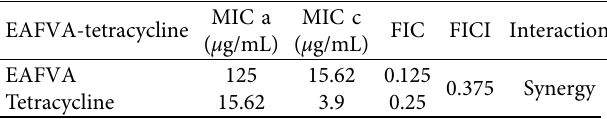
Table 3: MIC alone value and MIC combination value of EAFVA with the combination interaction on MRSA.